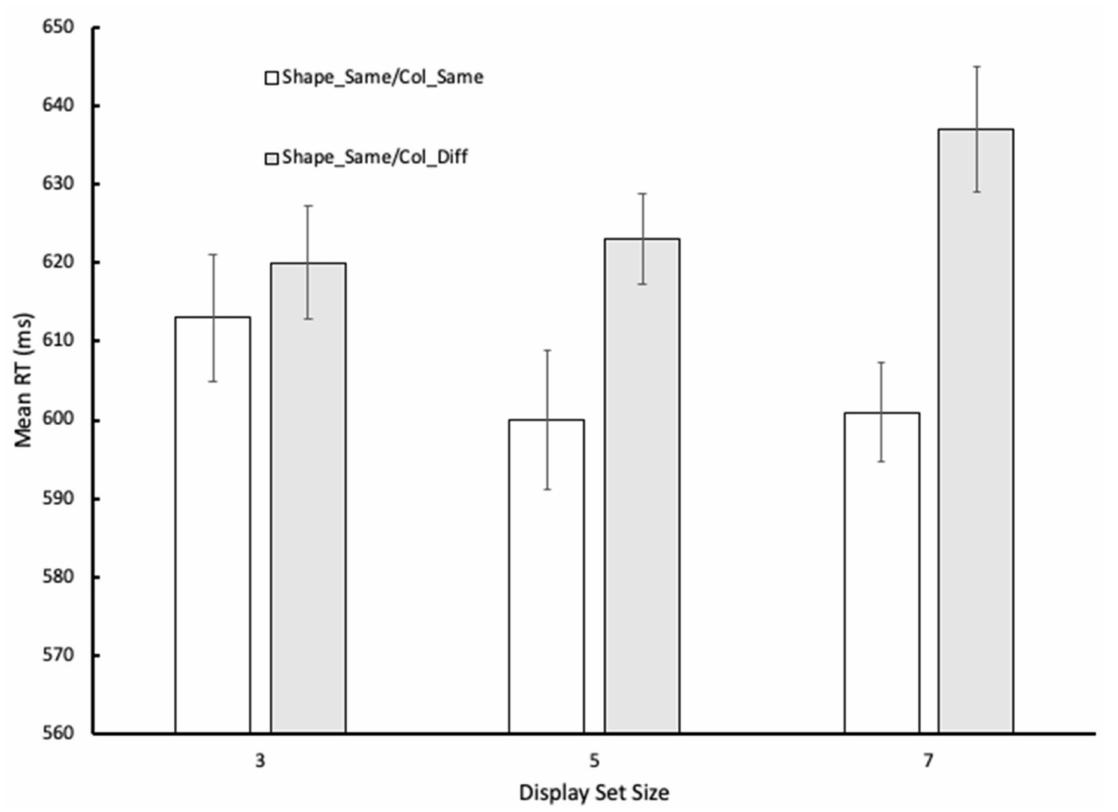
Figure 4. Graphical illustration of the mean RTs for the control conditions in Experiment 2. Error bars reflect 95% Cis, as recommended by Bakeman and McArthur